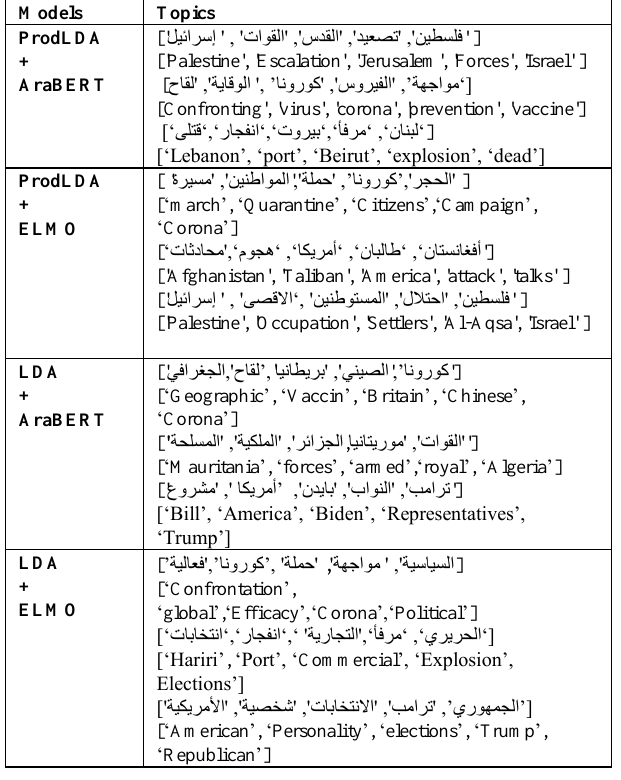
Table 2 . Top five words of three topics extracted by compared